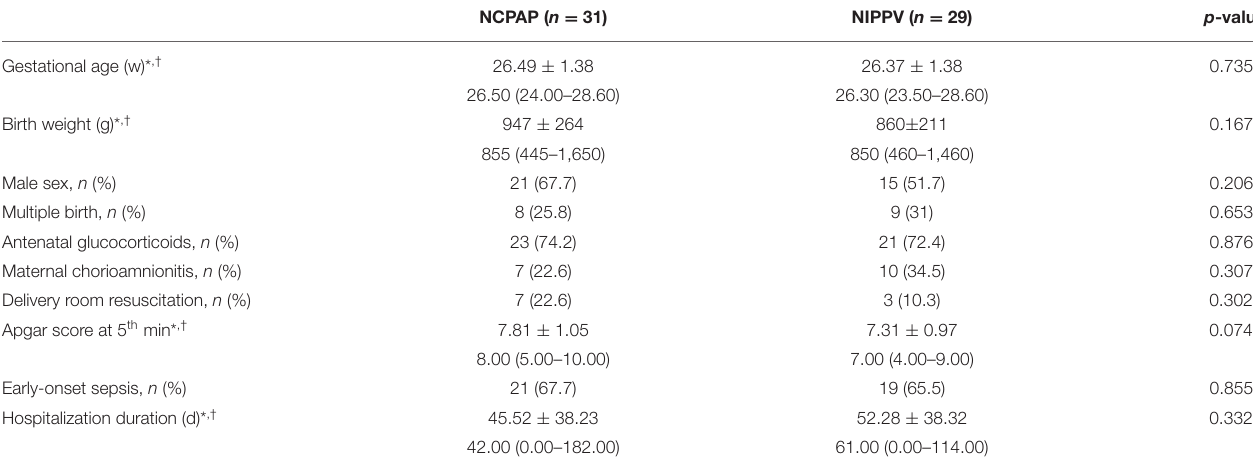
TABLE 1 | Demographic and clinical conditions of the groups.